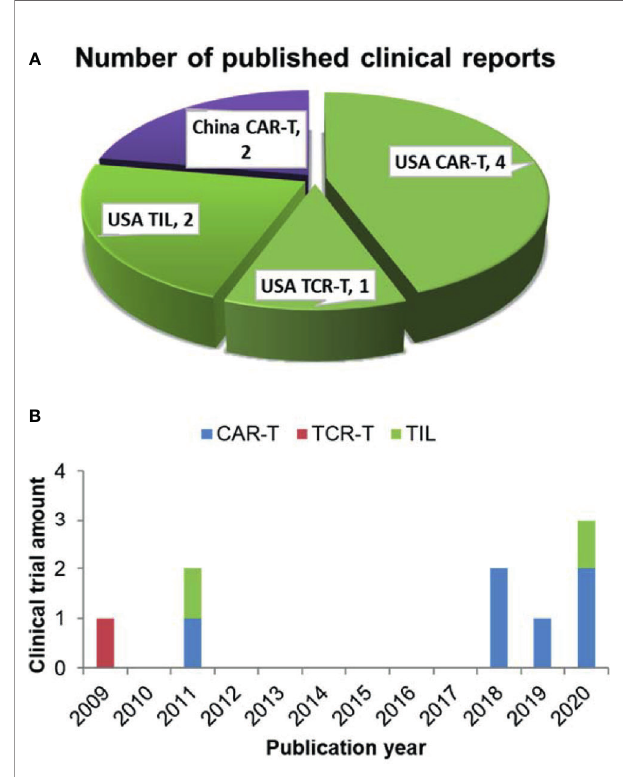
FIGURE 1 | Literature review of clinical trials analyzing differentiation phenotypes of the infused T cells and their anti-cancer outcomes. (A) Number of the published clinical reports from different countries (purple for China, green for USA). (B) The amount of clinical trials with various T-cell therapy types published in different